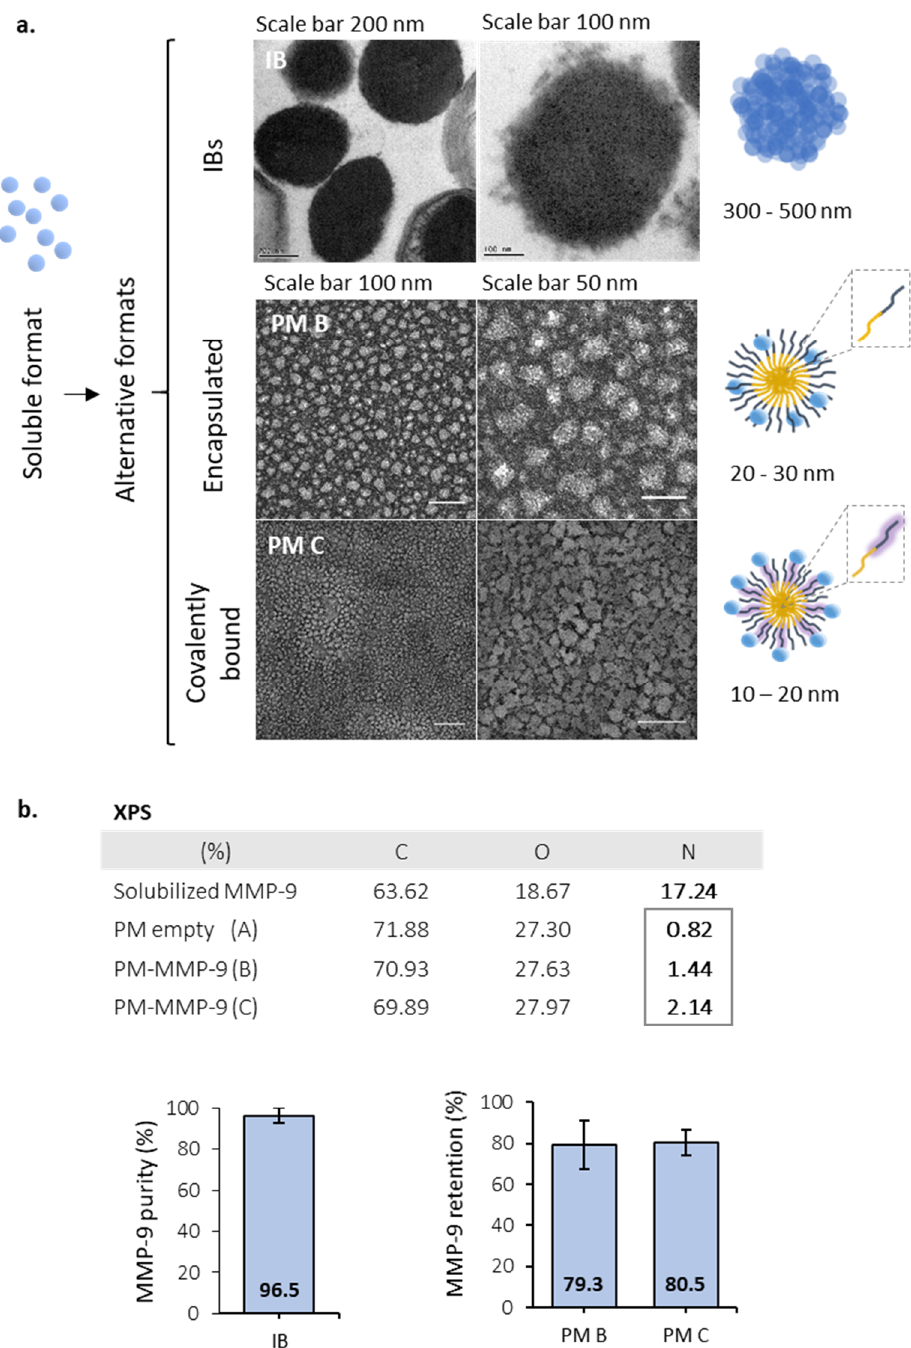
Figure 1. Description for the MMP-9 formats. ( a ) Transmission electron microscopy (TEM) images for MMP-9 IBs (IB), non-covalent MMP-9-nanopolymers (PM B), and covalent MMP-9-nanopolymers (PM C). Pictures represent the format structures for the soluble proteins, IBs, and Pluronic ® F127 amphiphilic polymers. Magnified, F127 hydrophobic chains are represented in yellow, and hydrophilic chains in dark blue. In PM C, the carboxylated chains of polymer (F127:COOH) are represented in dark blue within a pruple shadow and correspond to 25% of the total polymer (ratio 1:4). Soluble MMP-9 are represented as single blue spheres. ( b ) XPS results summary showing elemental composition on the surface of MMP-9, non-loaded PM (A), and MMP-9 loaded PM by the two strategies previously mentioned (PM B and PM C). Panels below, on the left MMP-9 purity of IBs. On the right, protein encapsulation efficacy for both types of PM tested. Bars depict SE.